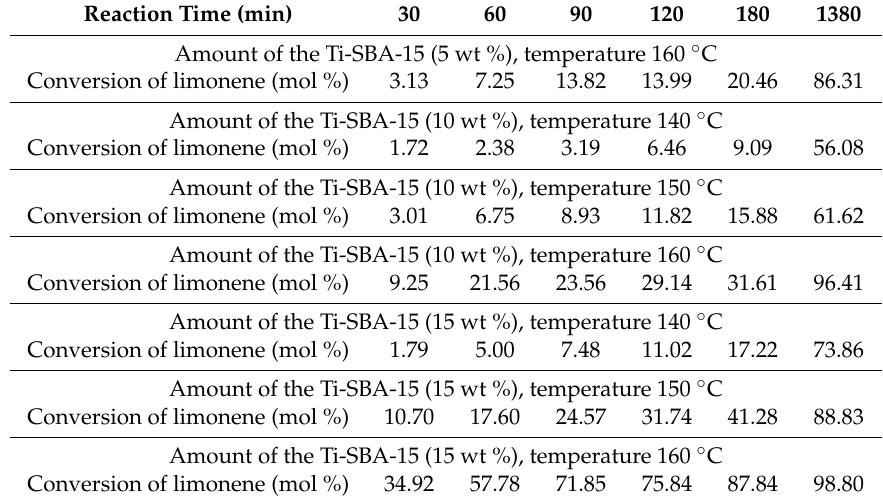
Table 1. The influence of reaction time, catalyst content and temperature on the limonene conversion.